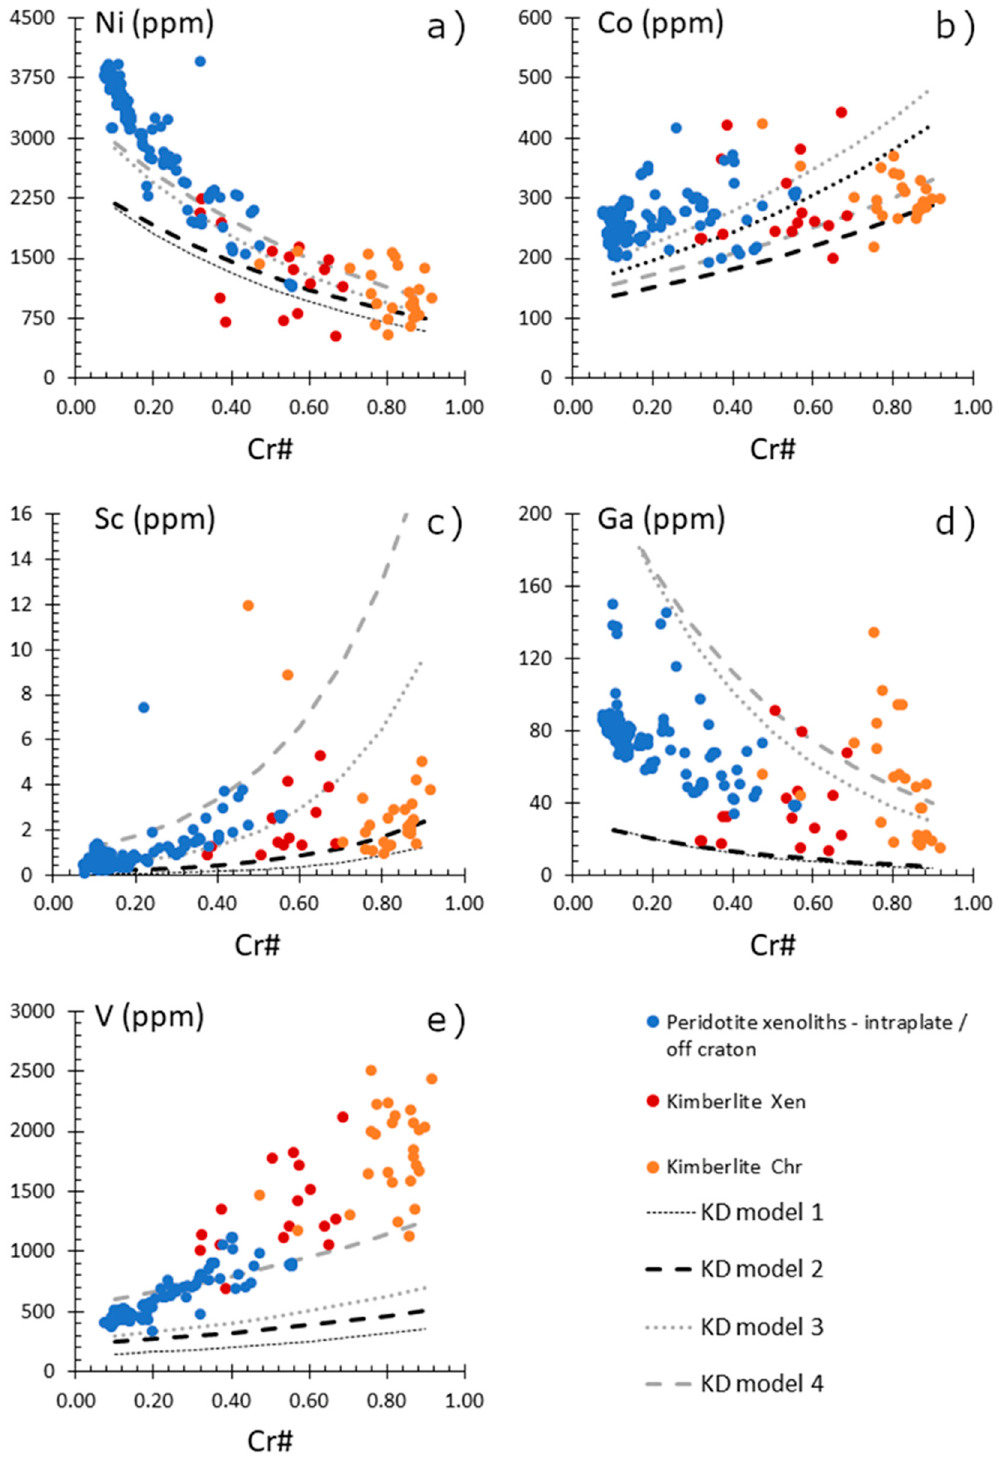
Figure 5. Cr# vs. Ni ( a ), Co ( b ), Sc ( c ), Ga ( d ) and V ( e ) for the Cr-spinels from this study and from peridotite xenoliths of continental settings (see Figure 3 for references and symbols). Solid and dashed curves show the variations of these elements as a function of Cr#, calculated using the partitioning models of Witt-Eickschen and O’Neill (2005) [15]: 800 °C and 2780 ppm Ni in olivine (KD model 1), 1000 °C and 2780 ppm Ni in olivine (KD model 2), 800 °C and 3749 ppm Ni in olivine (KD model 3) and 1000 °C and 3749 ppm Ni in olivine (KD model 4).